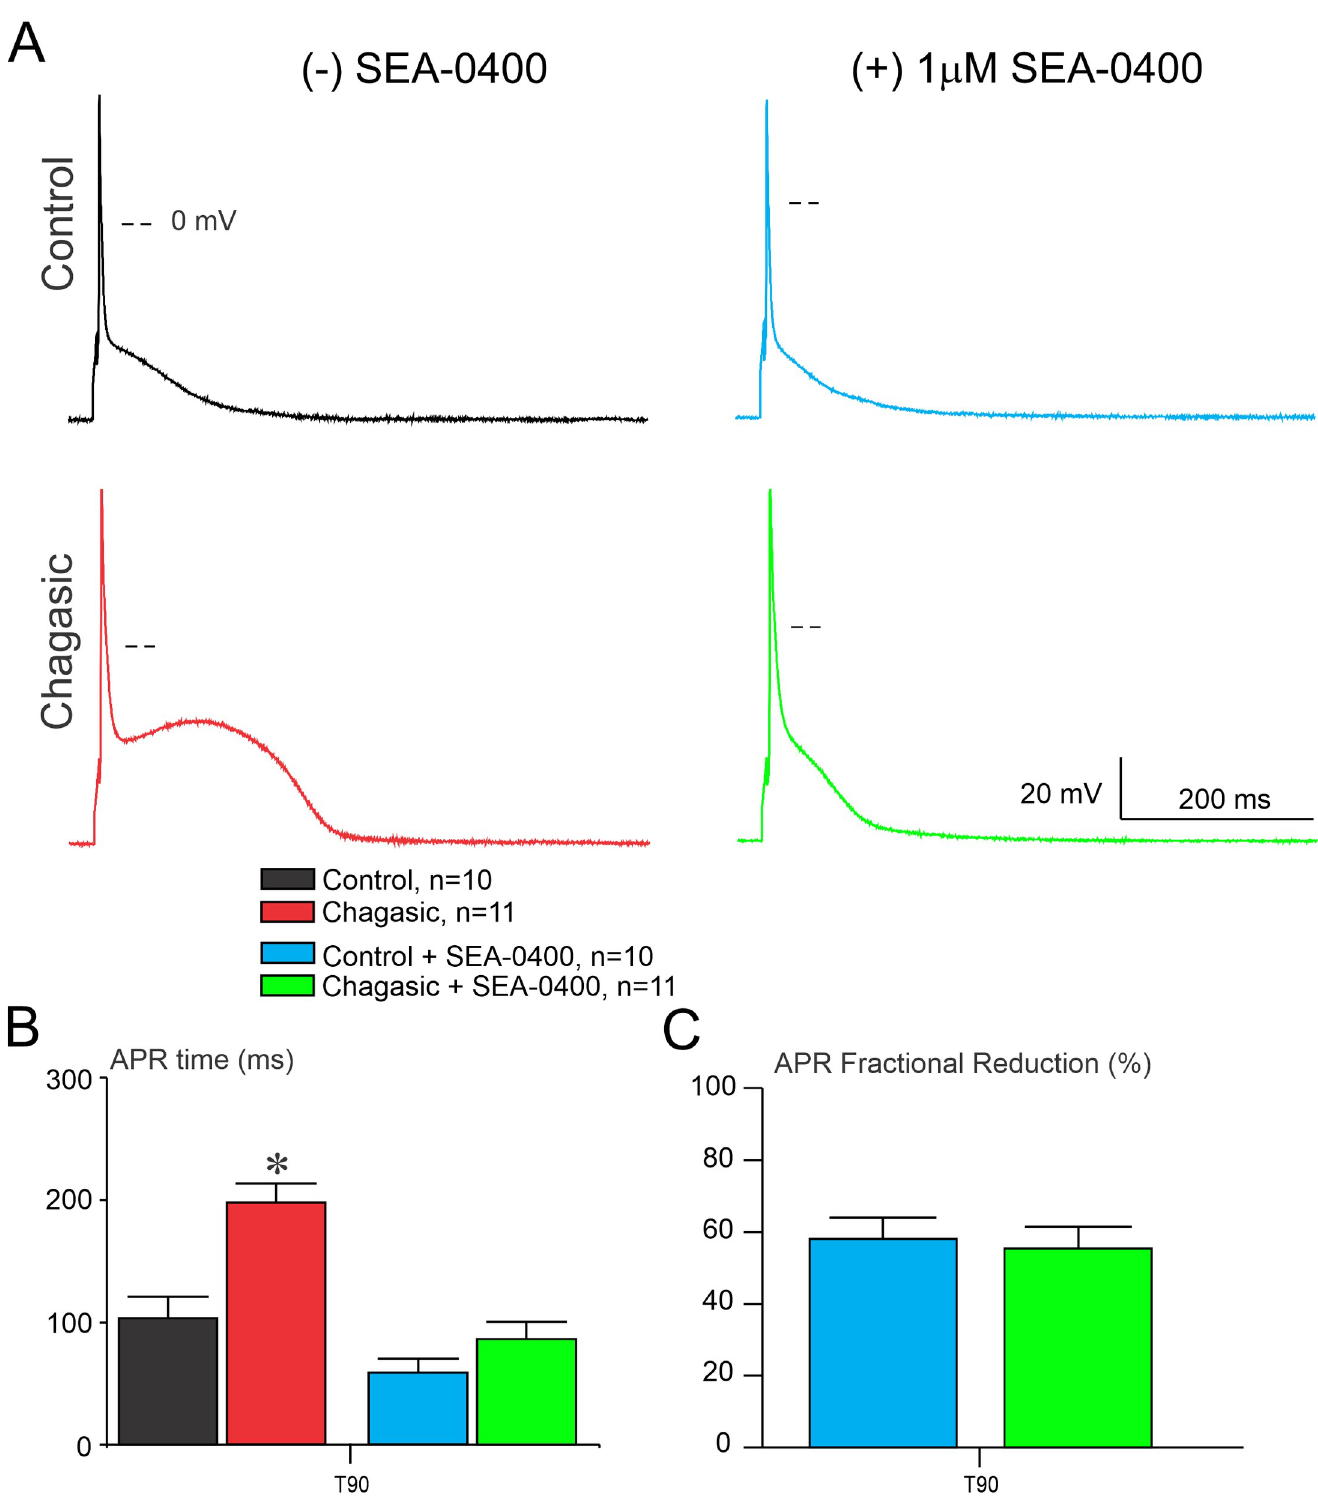
Fig 4. SEA0400 shorts action potential waveform in the chronic phase of experimental Chagas disease. (A) Representative AP recorded from cardiomyocytes isolated from control and infected mice, before and after perfusion of SEA0400 (1 μ M). (B) Time required to 90% (T 90 ) of full AP repolarization before and after exposure to SEA0400 (1 μ M). (C) AP repolarization (APR) fractional reduction taken at 90% after challenge cells with SEA0400 (1 μ M). Data were compared using one-way ANOVA (B) and Student’s t test (C). n represents the number of cells. � comparing Chagasic without SEA0400 to all other groups (p < 0.05).